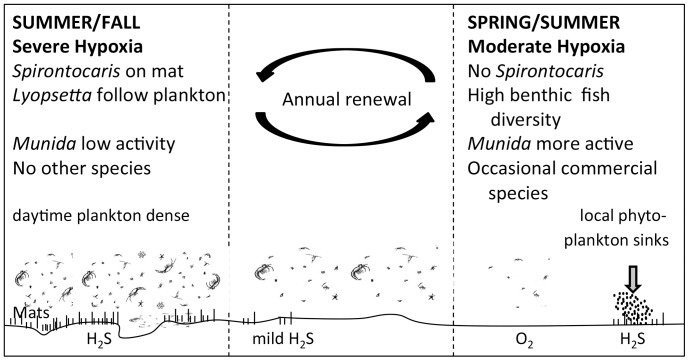
Observations and underlying processes occurring at different levels of hypoxia in Saanich Inlet.Diagram summarizes seasonal changes and effects on benthic communities inhabiting the hypoxic zone of Saanich Inlet (BC, Canada). Gradual depletion of oxygen in the basin following the spring phytoplankton bloom leads to the development of bacterial mats on the seafloor. Changes in oxygen indirectly affect the benthic community through: i) food availability by controlling access to downwardly migrating zooplankton, and the growth of bacterial mats on the seafloor, and ii) disturbance/predation with greater activity occurring in higher oxygen concentrations. Note that H2S can be released during moderate hypoxia in response to local bacterial decomposition in surface sediments (e.g. following a plankton bloom).